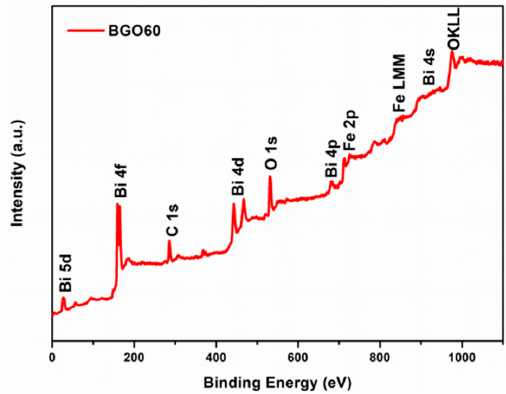
Figure 5. Full survey spectrum of BGO60.